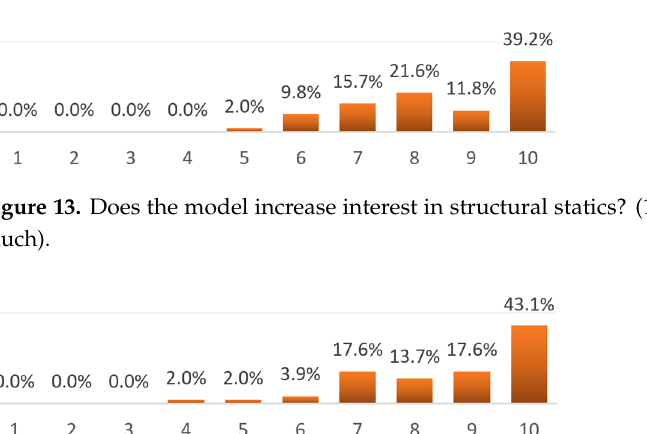
Figure 12. Does the physical model enhance the intuitive understanding of how the truss works? (1—absolutely no, 10—yes, very much).